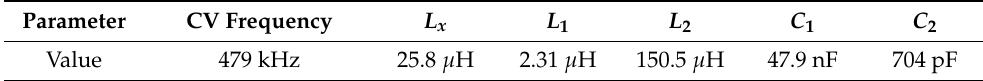
Table 1. The CV operating frequency and compensation parameters.